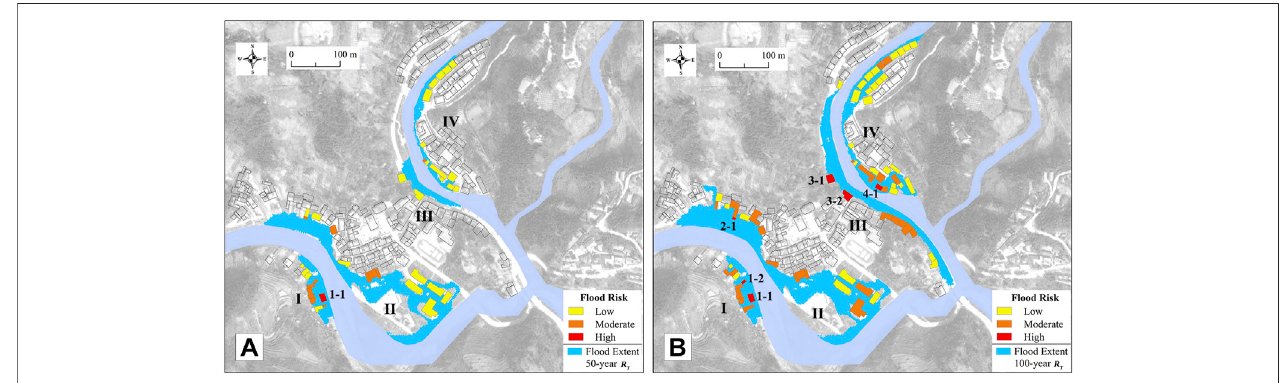
FIGURE 12 | The fl ood risk of buildings in the fl ood scenarios with (A) 50-year and (B) 100-year R T .